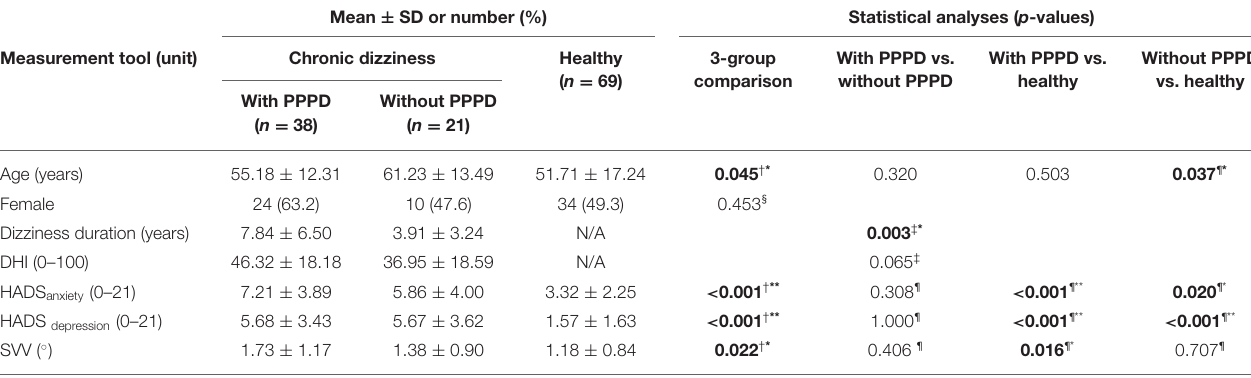
TABLE 2 | Results on descriptive variables of the included participants a,b . Measurement tool (unit) Chronic dizziness Healthy